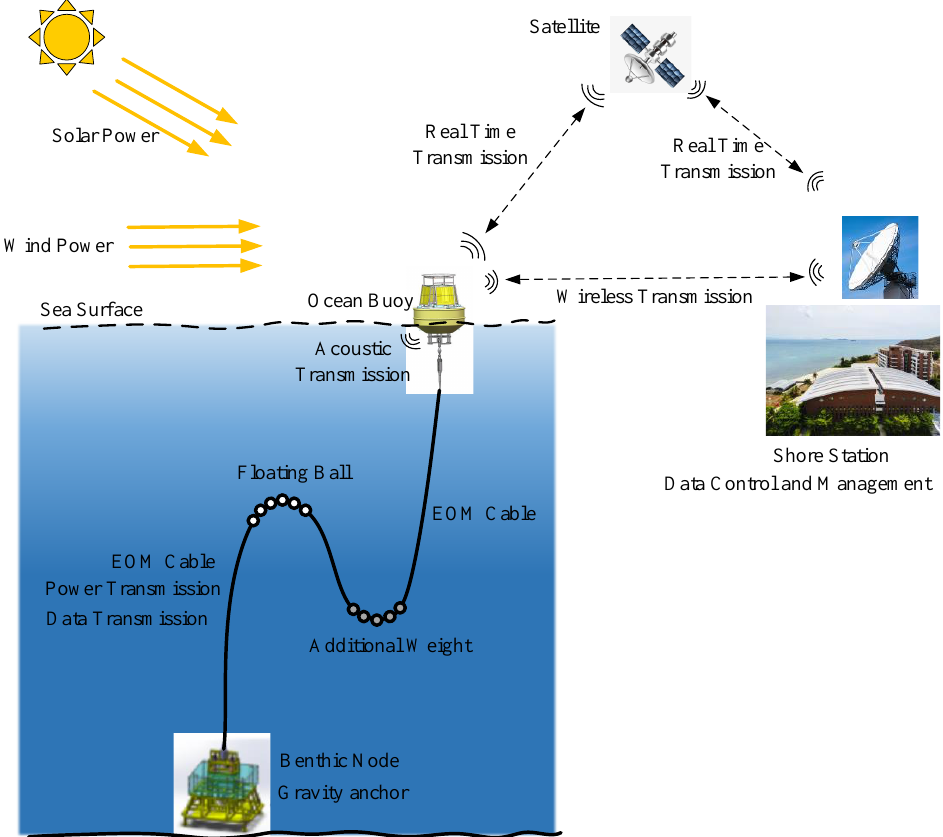
Figure 4. Concept design of Mooring Buoys Observation System for Benthic with Electro-Optical-Mechanical Cable (MBOSBC).